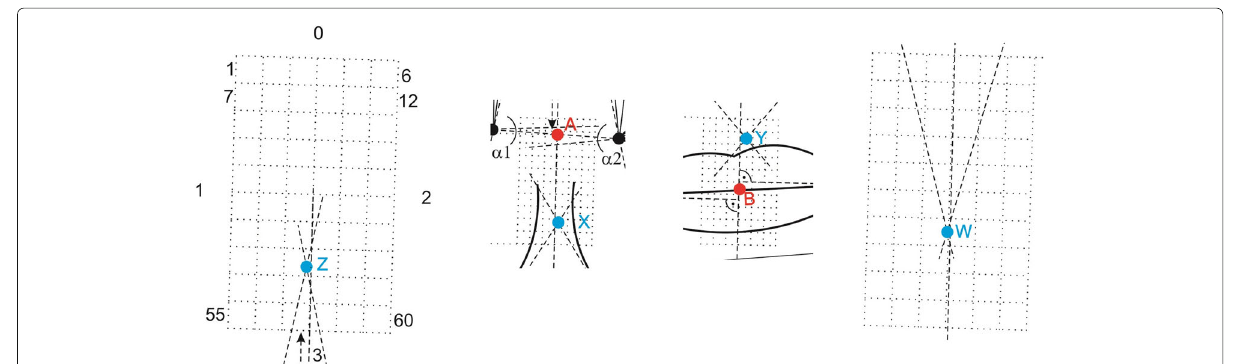
Fig. 11 Four template grids of facial asymmetry for encoding the last four